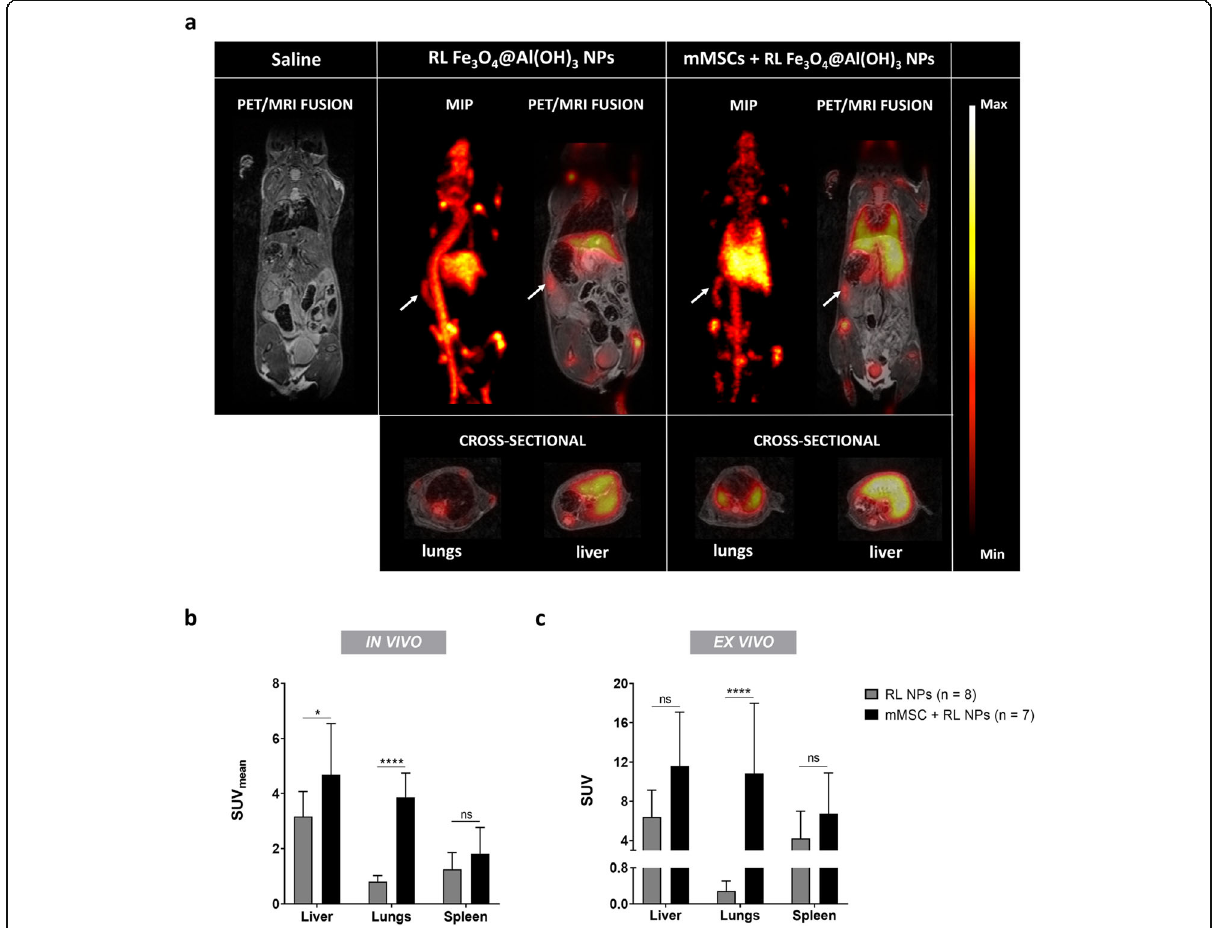
Fig. 2 In and ex vivo biodistribution of 18 F-labeled Fe 3 O 4 @Al(OH) 3 NPs or mMSCs labeled with these NPs. Mice were injected intravenously with saline, 18 F-labeled Fe 3 O 4 @Al(OH) 3 NPs (radiolabeled or RL NPs), or 100,000 mouse mesenchymal stem cells (mMSCs) labeled with RL NPs (mMSCs + RL NPs) while simultaneous PET/MRI images were acquired. a Representative maximum intensity projection (MIP) images and overlays of T 2 - weighted anatomical MR images and 18 F-PET images (SUV = 0 – 9) show the uptake of 18 F-labeled Fe 3 O 4 @Al(OH) 3 NPs in the liver, while mMSCs labeled with RL NPs mainly accumulate in the lungs. In the latter group, signal from free NPs was also detected in the liver. Furthermore, uptake of 18 F-labeled Fe 3 O 4 @Al(OH) 3 NPs can be appreciated in the spleen of both groups, as indicated by the white arrows. b , c Corresponding quantification of b in vivo and c ex vivo standardized uptake values (SUV) of the liver, lungs, and spleen confirm the images. In vivo values represent the average SUV over the 1h scan time. Indicated statistics are based on two-way ANOVA between the different groups with Bonferroni ’ s multiple comparisons test (* p < 0.05, **** p < 0.0001, ns, not